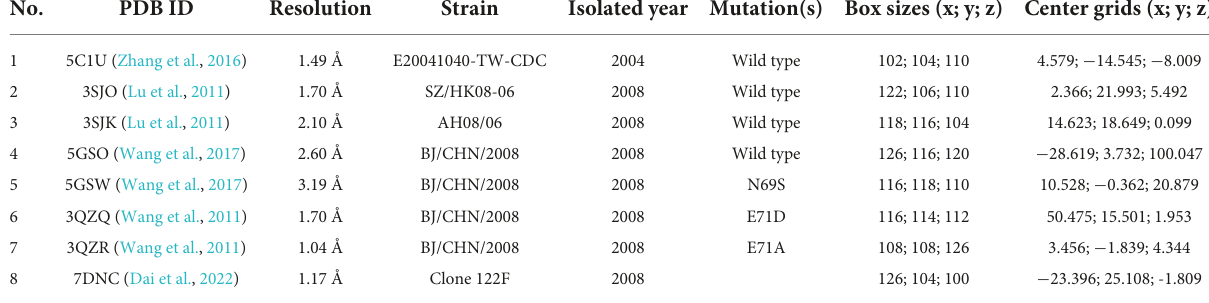
TABLE 1 Data collection of 3C pro proteins used in this study and their relevant information.